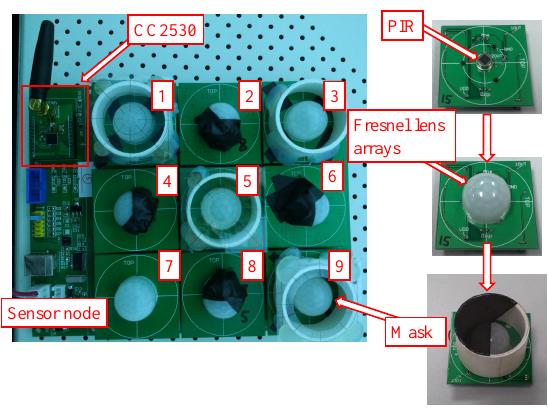
Figure 2. The pyroelectric infrared (PIR) sensor node. The sensor node consists of nine PIR sensors arranged in a grid shape. Four of them using the Type I mask, the rest using the Type II mask. CC2530 is used to sample the PIR signals and communicate with the sink node.